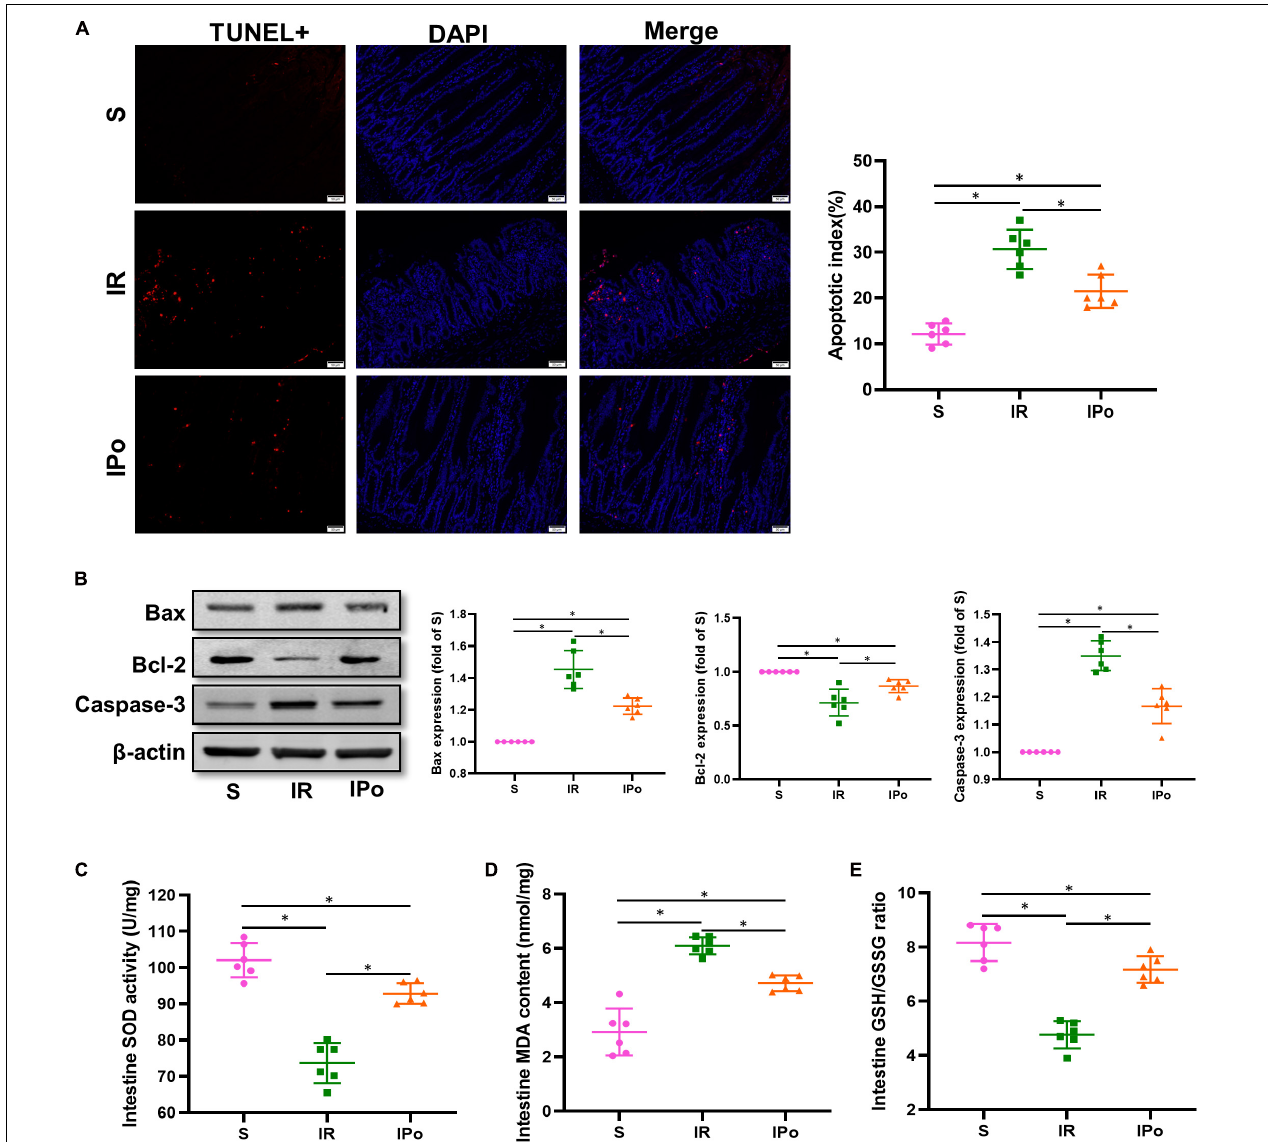
FIGURE 3 | Ischemic postconditioning ameliorates myocardial IR-induced apoptosis and suppresses oxidative stress. (A) The TUNEL staining for cell apoptosis rates. (B) Expression of apoptosis-related proteins Bax, Bcl-2, and caspase-3. (C) SOD. (D) MDA. (E) GSH/GSSG ratio. β -actin was detected as loading